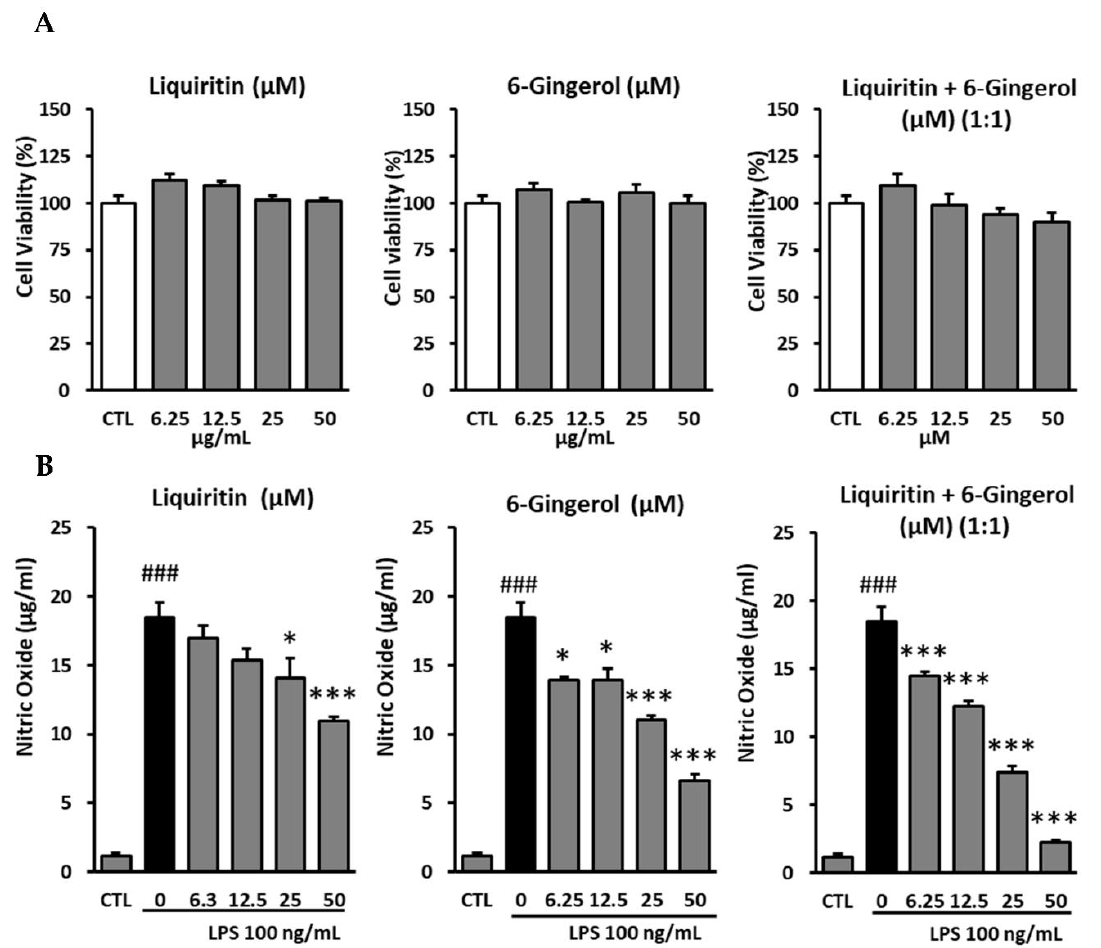
Figure 4. Inhibitory effects of liquiritin and 6-gingerol on RAW 264.7 cells. ( A ): Cytotoxic effects of liquiritin and 6-gingerol on RAW 264.7 cells. ( B ): Inhibition of nitric oxide production by liquiritin and 6-gingerol in LPS-mediated RAW 264.7 cells. The cells were pre-treated with various concentrations of liquiritin and 6-gingerol, following which the cells were treated with LPS (100 ng/mL). After 24 h, the nitric oxide levels in the culture medium were measured using Griess reaction. The data are presented as mean ± SEM. Statistical significance was assessed by means of ANOVA followed by Tukey’s post-hoc test, using software R version 3.3.3. ### p < 0.001, compared to the normal group; * p < 0.05, and *** p < 0.001, compared to the LPS-treated group.